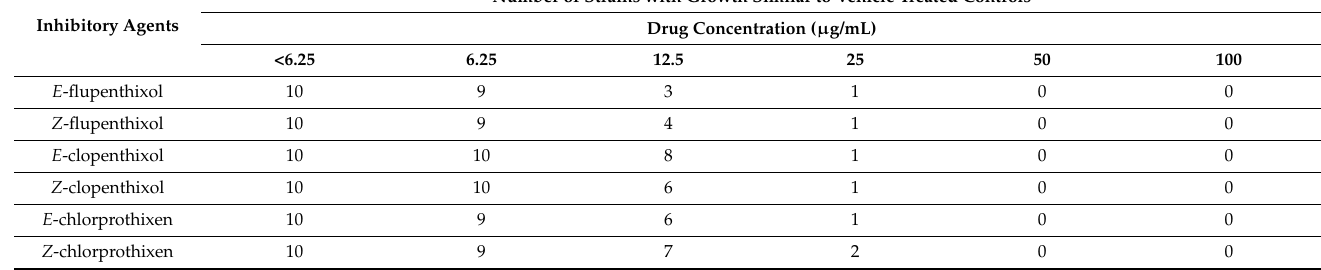
Table 8. The susceptibility of 10 slow-growing mycobacteria to 6 different Z - and E -thioxanthene